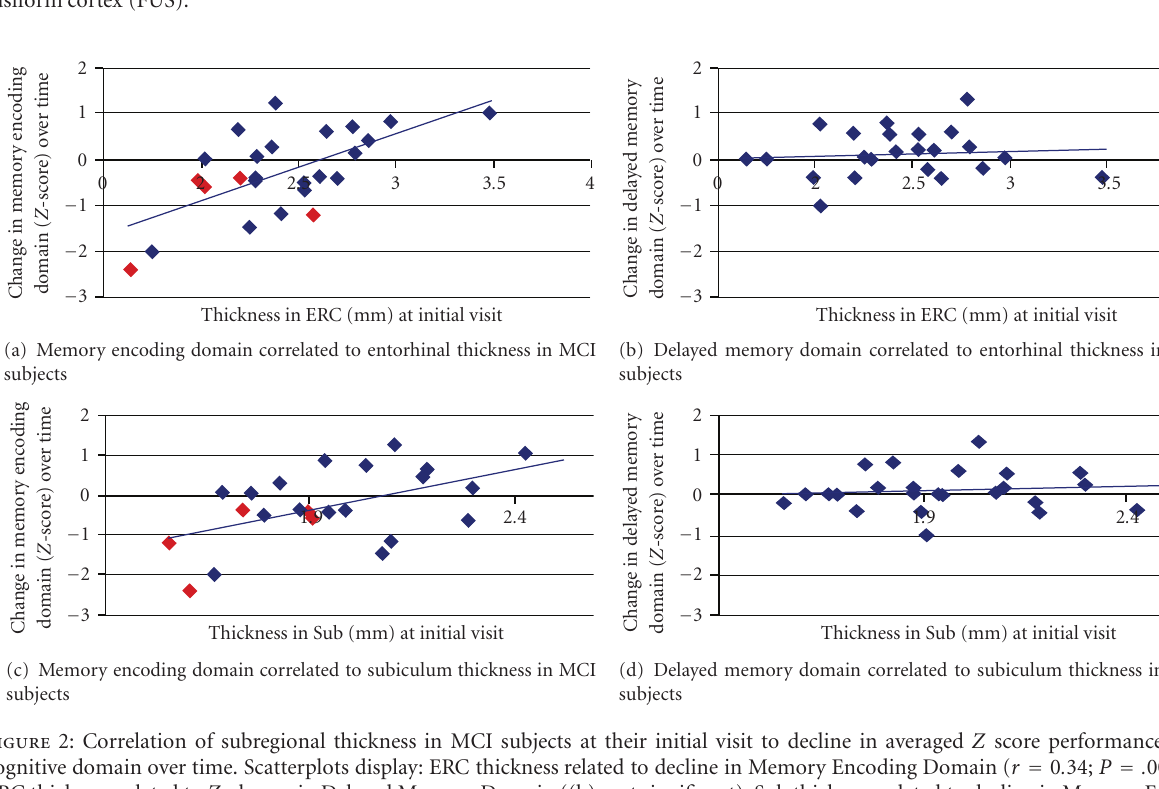
Figure 1: Segmentationand Unfolding of Hippocampal Subregions. High-resolution imageswere segmented (a) defining gray matter within the MTL. Boundary demarcations were drawn on the in-plane image and projected to flat map space (b) including CA fields 2, 3 and the dentate gyrus (CA23DG), subiculum (Sub), entorhinal Cortex (ERC), perirhinal cortex (PRC), parahippocampal cortex (PHC), and fusiform cortex (FUS).